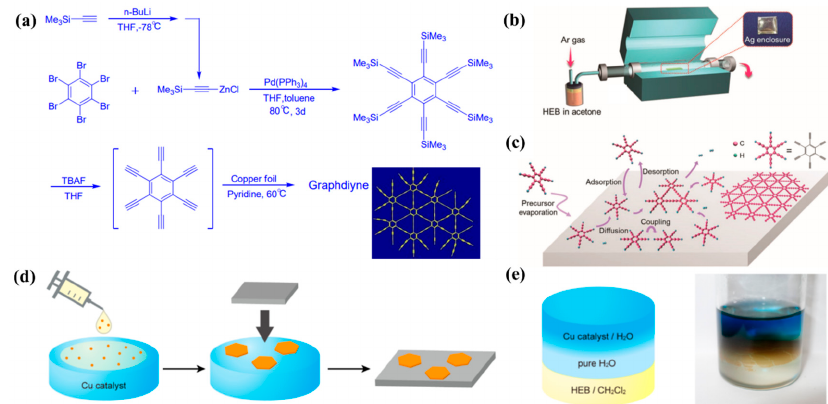
Figure 2. Syntheses of GDY. ( a ) Synthetic route of GDY film by copper foil method (reproduced